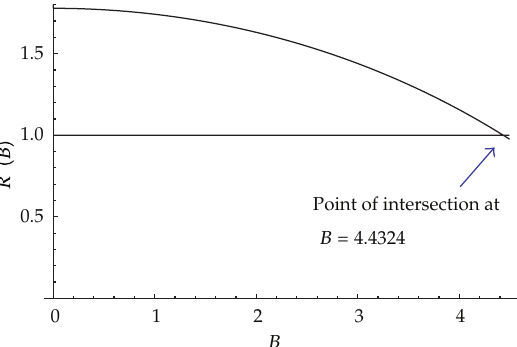
Figure 11: Graph of the ratio R (cid:3) B (cid:4) for 0 ≤ B ≤ B 1 , where B 1 (cid:5) 4 . 4934. The point of intersection of the two curves is B (cid:5) 4 .